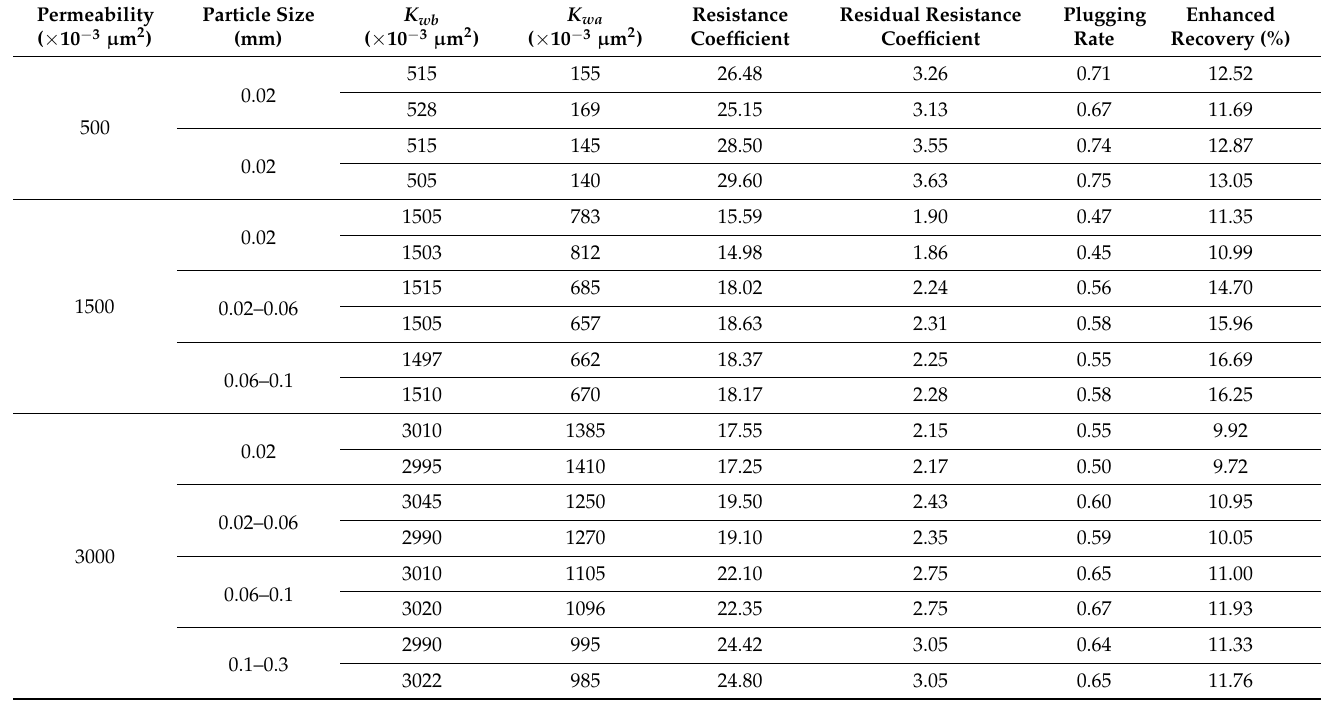
Figure 5. Injection of 0.02–0.06 mm asphalt binder. Asphalt suspensions of different particle sizes with a concentration of 3500 mg/L were injected at a constant flow rate of 3 mL/min. After the experiment, the pressure dif- ference between the two ends of the core was used to calculate the K wb (permeability before the injection of asphalt profile control agent), K wa (after the injection of the asphalt profile control agent, the permeability), resistance coefficient, residual resistance coefficient, plugging rate, and recovery rate increase value—the specific values are shown in Table 3 below. Table 3. Experimental results of cores with different permeability.